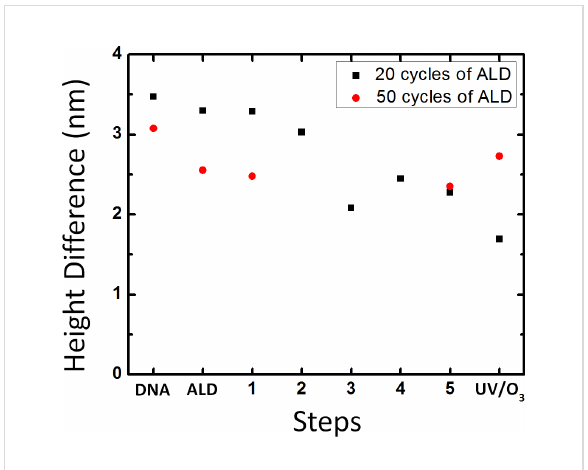
Figure 5: Comparison of the height differences between the maximum peaks of the histograms in Figure 3i and